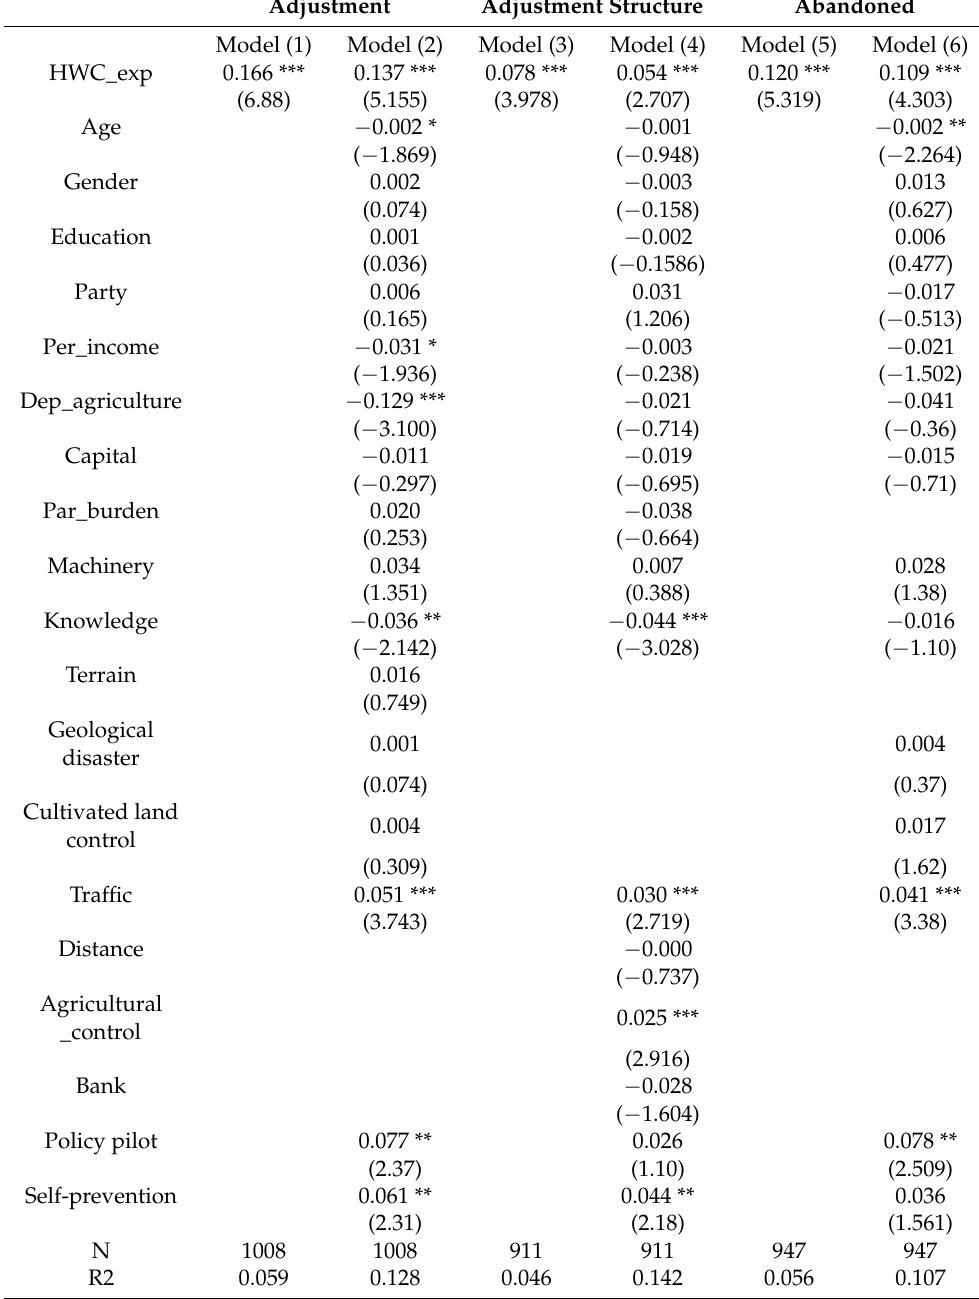
Table 3. Basic regression results of the influence of HWC on the adjustment of cultivated land use behaviour of